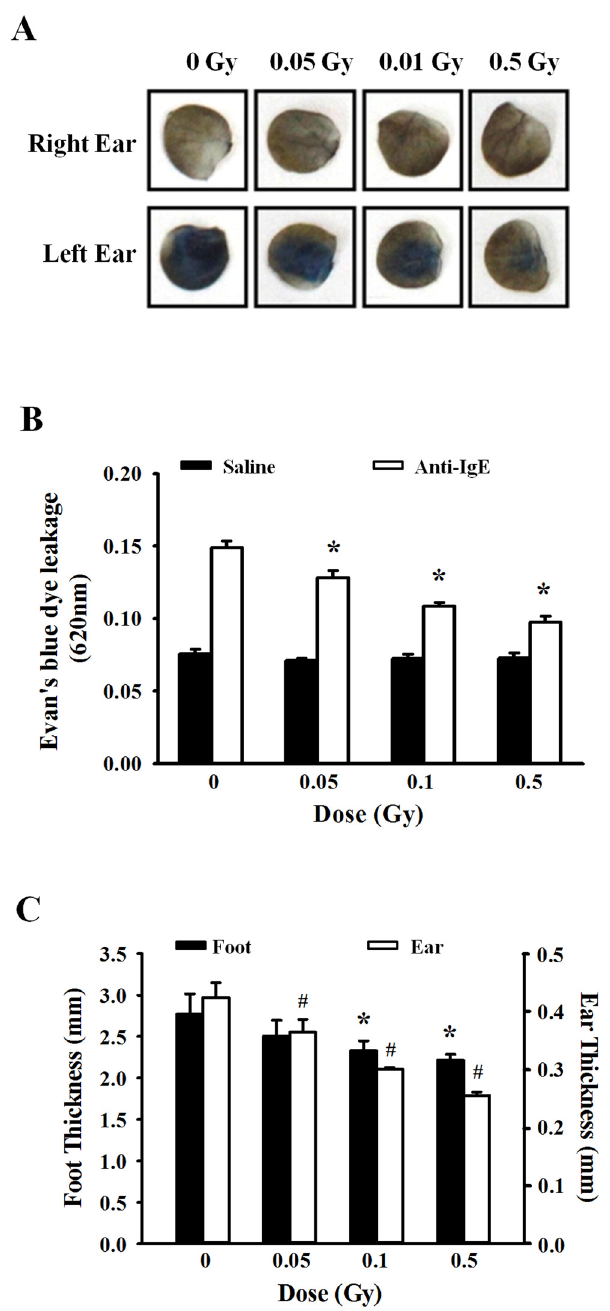
Fig 6. Effects of ionizing radiation in IgE-mediated passive cutaneous anaphylaxis and the late-phase cutaneous model. Anti-DNP (20 ng) was injected intradermally in the left ear, whereas the right ear was injected with saline as a control. After 24 h, mice were irradiated with 0 – 0.5 Gy before injection of 100 μ g DNP-HAS containing Evan ’ s blue dye via the tail vein. (A) After 30 min, ear punches (8 mm) from both ears were collected and used for extraction of the Evan ’ s blue dye (B). The optical density was measured at 620 nm. (C) Mice were passively sensitized by i.v. injection of 2 μ g anti-DNP IgE. After 24 h, mice were irradiated with 0 – 0.5 Gy before 20 μ l of 0.3% DNFB in acetone/olive oil (4:1) was applied epicutaneously to both sides of the left hind paw and left ear. Acetone/olive oil (20 μ l) was applied to the right ear and right hind paw as a control. After 24 h, the thicknesses of the ear and hind paw were measured using a digital microcaliper. Data represent the mean ± SEM from five independent experiments. * p < 0.05, #p < 0.05 versus the corresponding control group of foot and ear,